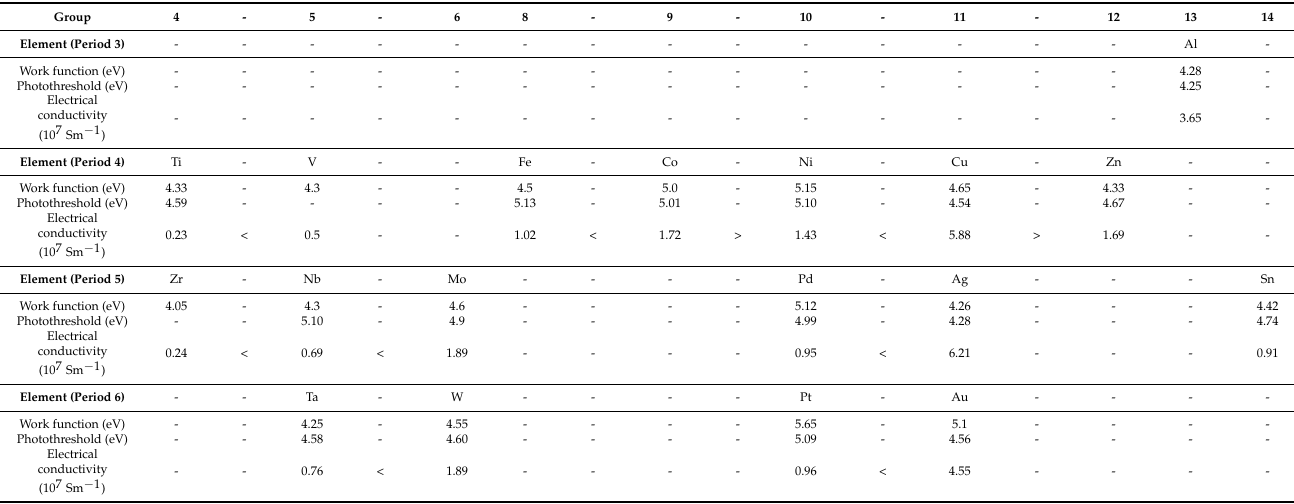
Table 3. The work function 1 , photothreshold at 298K 2 , and electrical conductivities at 295K 3 of the metals used in the periodic